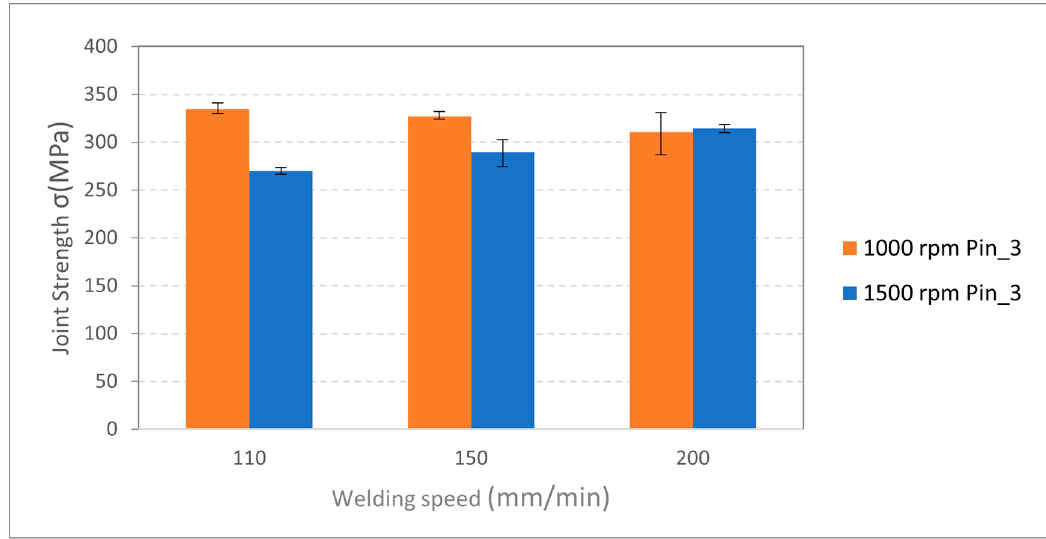
Figure 10. Comparison of tensile strength for joints for different welding speeds for 3 mm diameter pin tool.